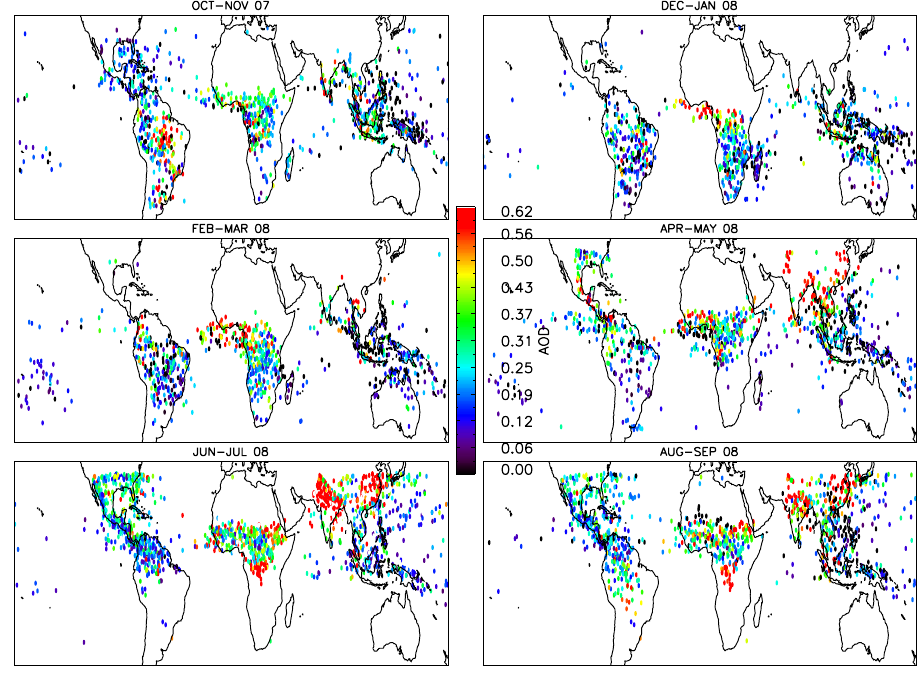
Fig. 6. Bimonthly maps from October 2007 to September 2008 of TRMM Mesoscale Convective Systems (MCS > 14km) tagged with MODIS Aerosol Optical Depth. The nearest AOD value of each MCS was extracted from MODIS AOD grids with a temporal and spatial resolution of 2 days and 3 ◦ lon × 3 ◦ lat. MCS that could not be tagged where no AOD value was available are in black. The AOD fields have been constructed using the MODIS Level 3 daily joint aerosol/water vapor/cloud product of the Terra space borne platform that cross the equator at 10:30 a.m.